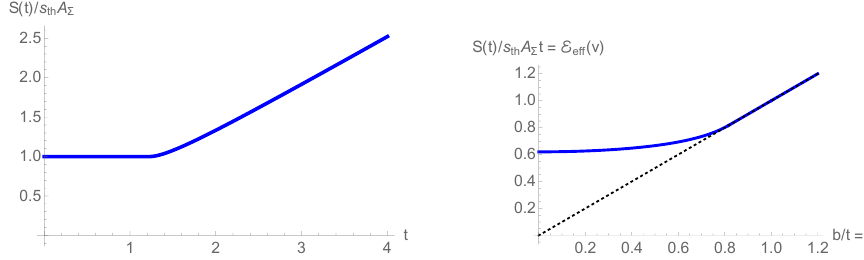
Figure 4 . Left: S ( t ) from (4.3) plotted for b = 1. The graph asymptotes to S ( T ) Right: if instead we (cid:12)x time, and plot the entropy as a function of v e(cid:11)ective membrane tension function to v for v > v B . A black dotted 45 (cid:14) line is added to guide the eye. The membrane ends at the tip of the brane, and from what is explained on (cid:12)gure 3 we